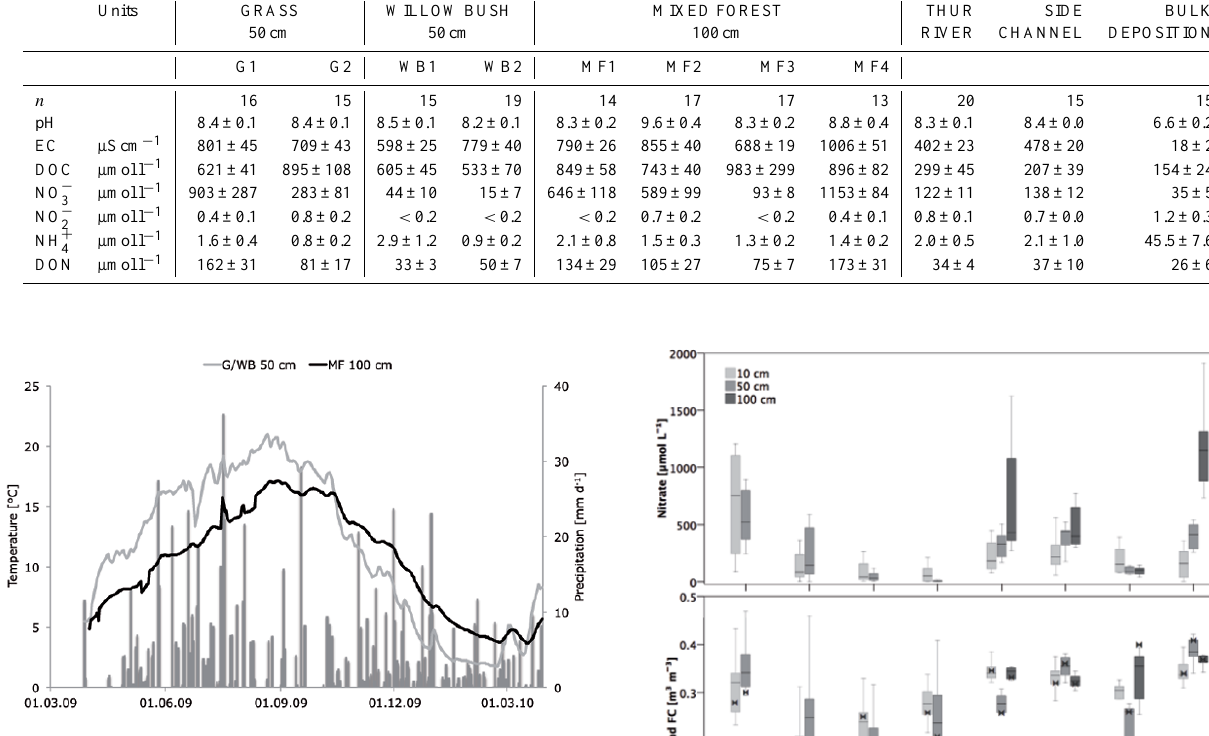
Fig. 3. Daily precipitation for the period from 28 March 2009– 29 March 2010 and daily average soil temperature at 50cm depth in GRASS and WILLOW BUSH and 100cm in MIXED FOREST.